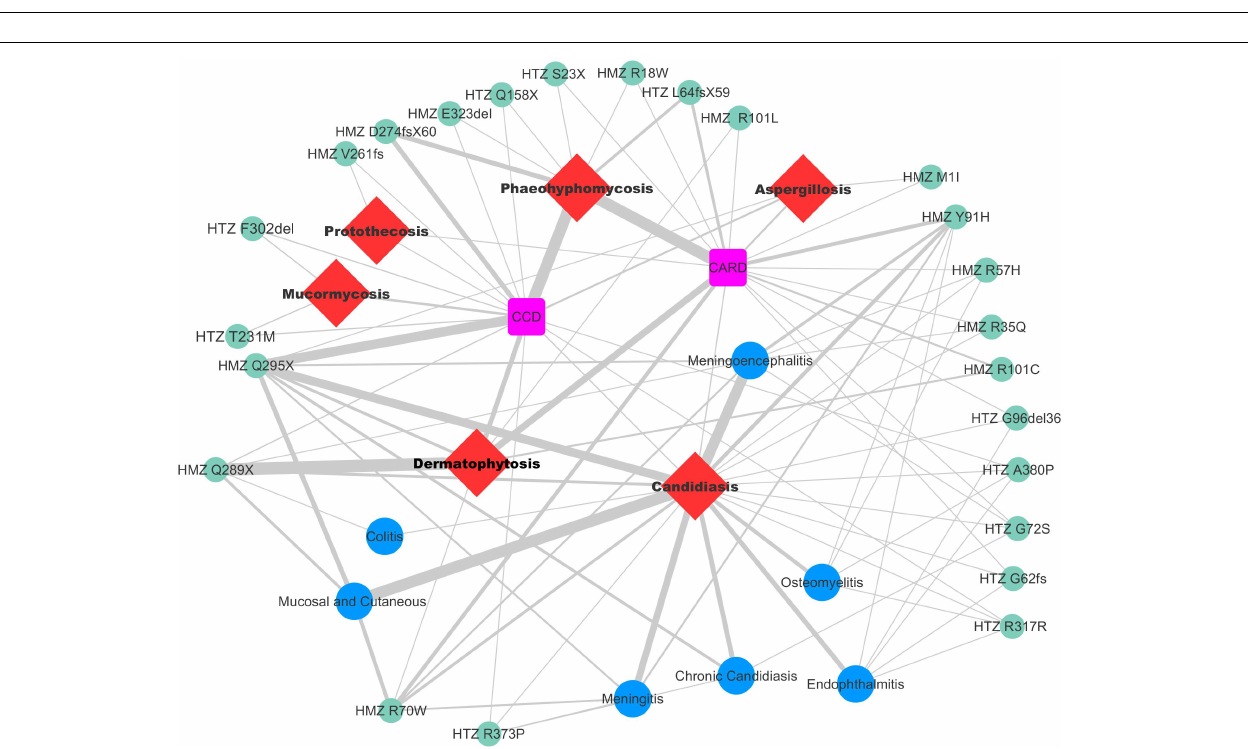
FIGURE 2 | Relation between the types of mutations and different clinical forms. Thick, short, and bold line indicates more reported cases with a mutation and clinical form; and less cases shown with thin and lane lines.